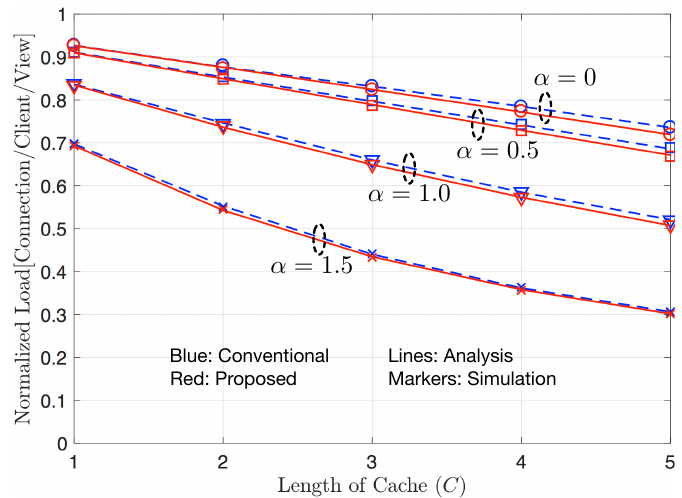
Figure 5. Average normalized load for various values of C . N =2, V = 20, and α